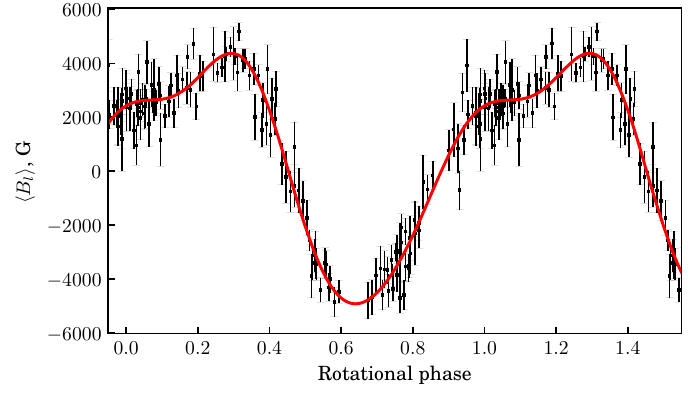
Figure 4. The longitudinal magnetic field of HD34736 phased with its rotational period.